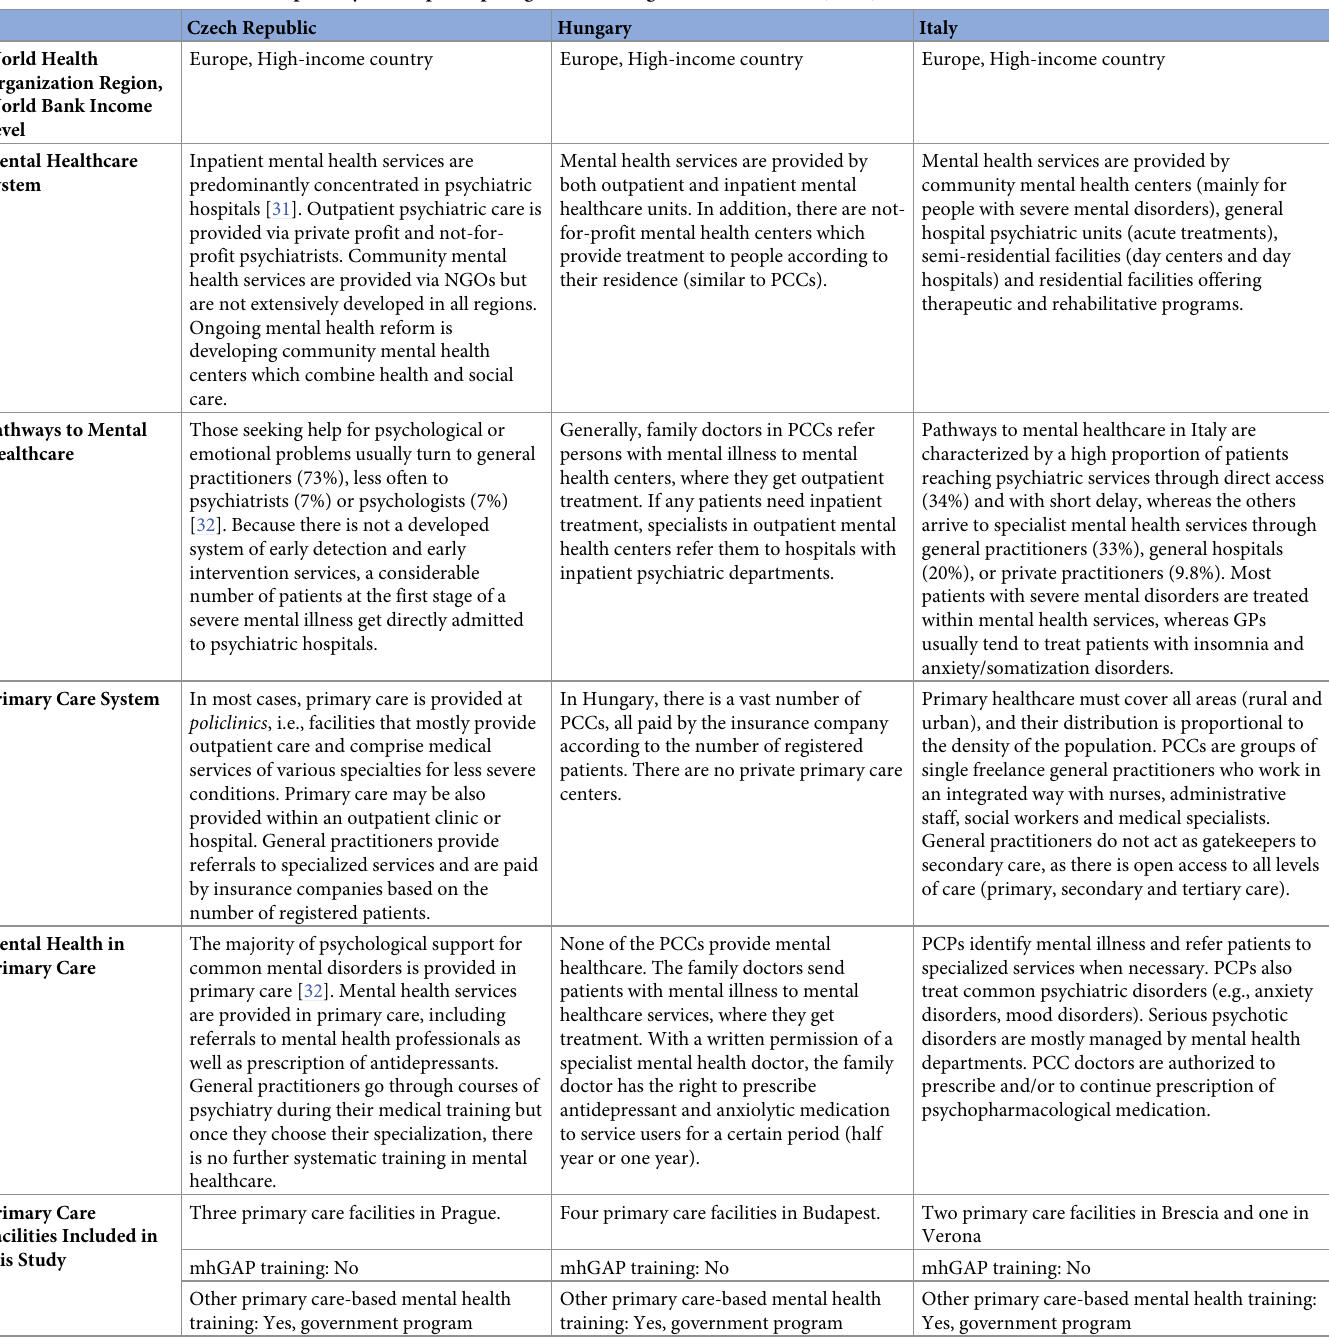
Table 2. Overview mental health and primary care in participating countries: High-income countries